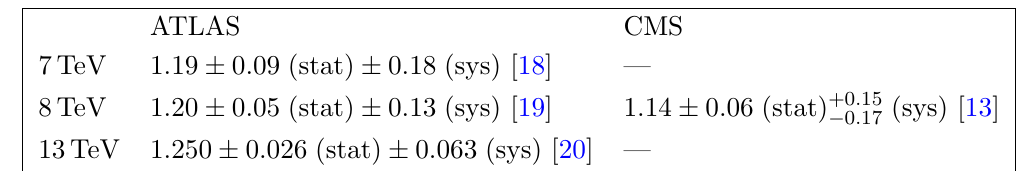
Figure 1 . Normalised d(cid:27)=d(cid:30) distribution (in bins of (cid:25)= 40) for the SM and the hypothetical case without spin correlation, for a CM energy of 8 TeV.